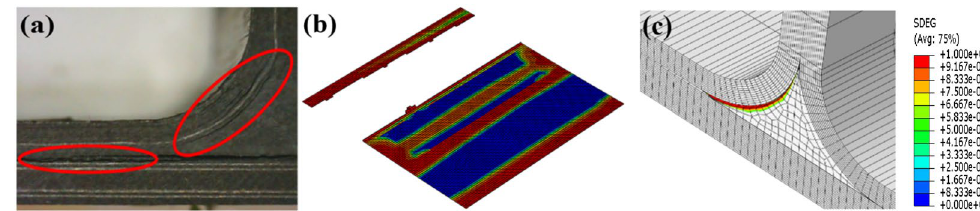
Figure 6. Failure modes of side bending interface without prefabrication defect: ( a ) Test result; ( b ) numerical result of adhesive layer; ( c ) numerical result of filler (ABAQUS 6.14, https:// www. 3ds. com/ produ cts- servi ces/ simul ia/ produ cts/ abaqus) 43 .